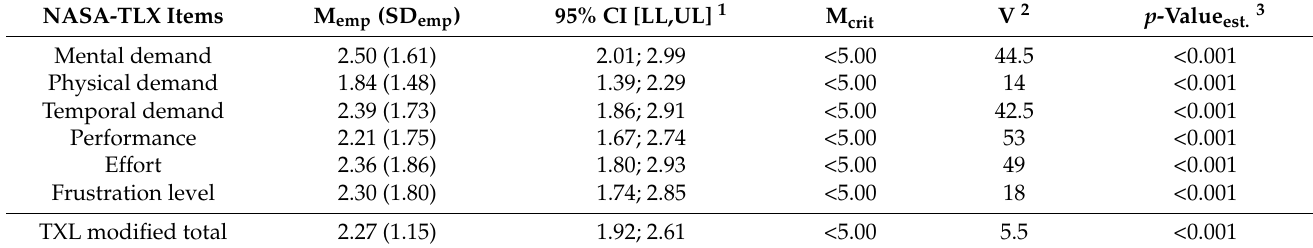
Table 6. NASA-TLX ratings of vStop HMI prototype by participants of the second user study (N = 44).